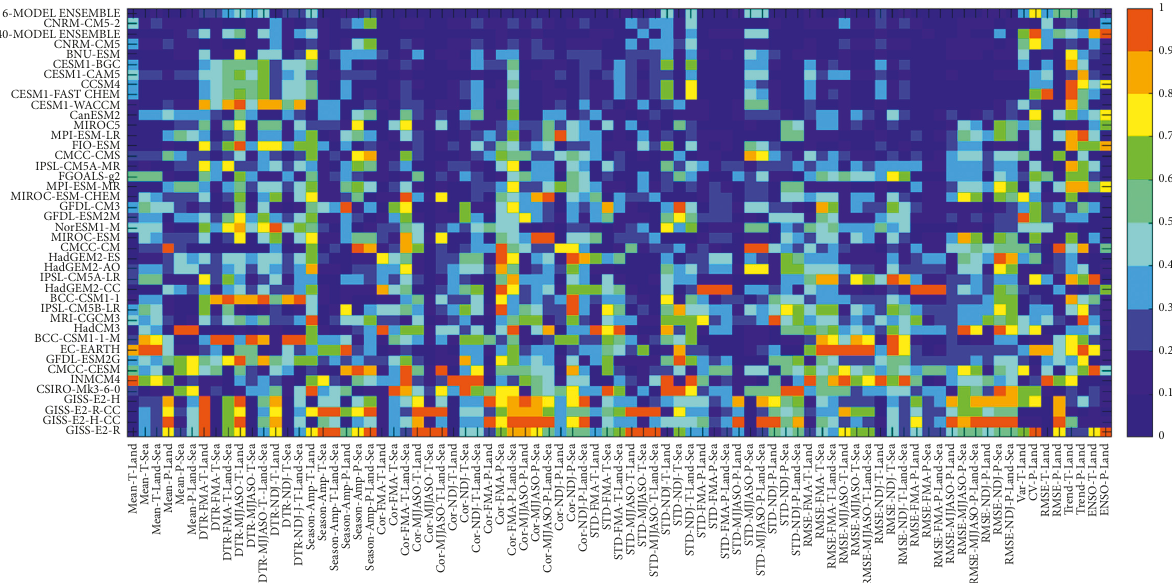
Figure 4: Relative error for each performance metric listed at the bottom for 40 GCMs, 6-GCM-Ensemble, and 40-GCM-Ensemble listed at the left in the order of lowest to highest total errors from top to bottom, respectively.